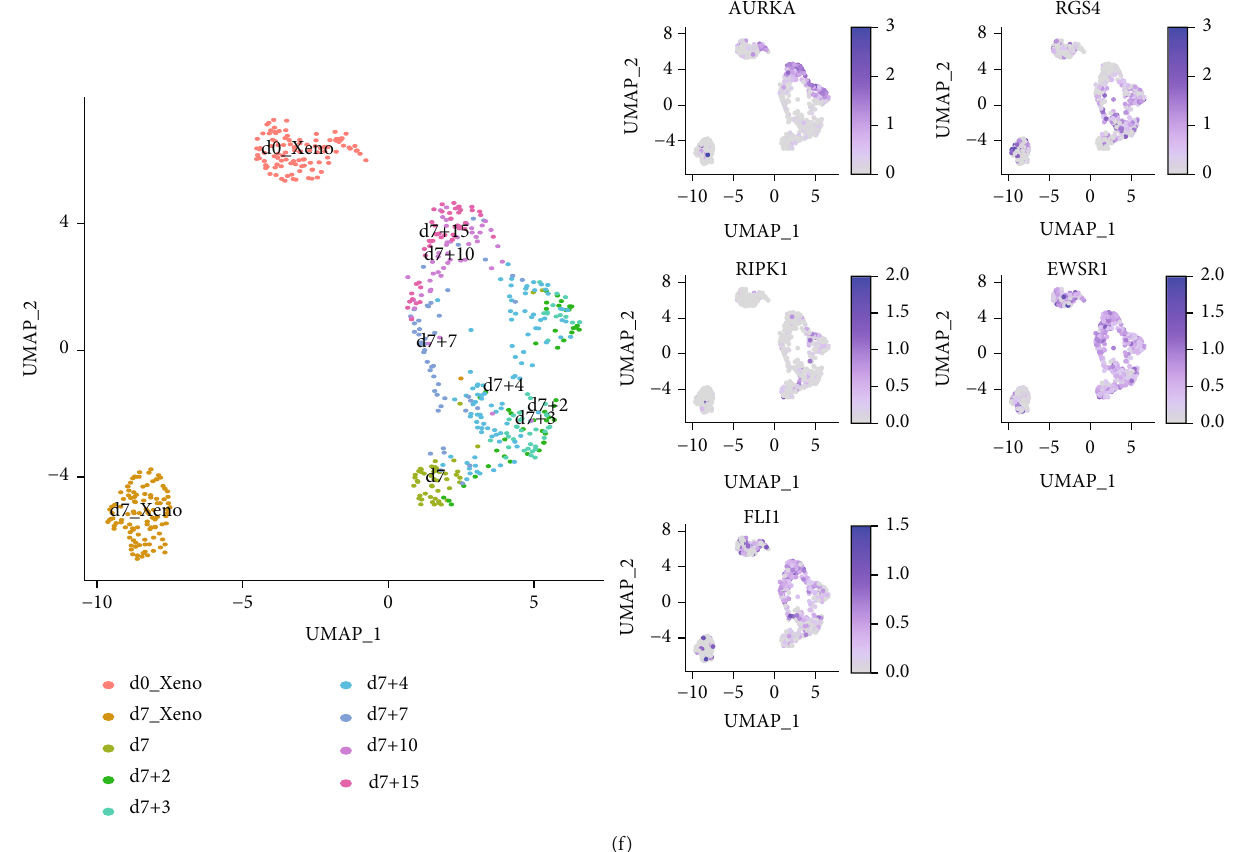
Figure 7: Comprehensive analysis of key genes. (a – c) Survival analyses of the 3 key genes. (d) Di ff erent expression of 3 key genes between tumor and normal tissue ( ∗ P < 0 : 05 ; ∗∗ P < 0 : 01 ; ∗∗∗ P < 0 : 001 ; ∗∗∗∗ P < 0 : 0001 ). (e) Correlation analysis between 3 key genes and EWSR1/ FLI1 ( ∗ P < 0 : 05 ). (f) Single-cell analysis: e ff ect of dynamic changes in ERWR1/FLI1 expression on the expression of 3 key genes (Xneo: A673 cell xenografts in a severe combined immunode fi ciency mouse. In a UAMP plot: one point represents a cell; the darker the color of the point, the higher the gene expression. The points on all UAMP plot are positioned consistently, and the UAMP plot on the left is used as the reference diagram).